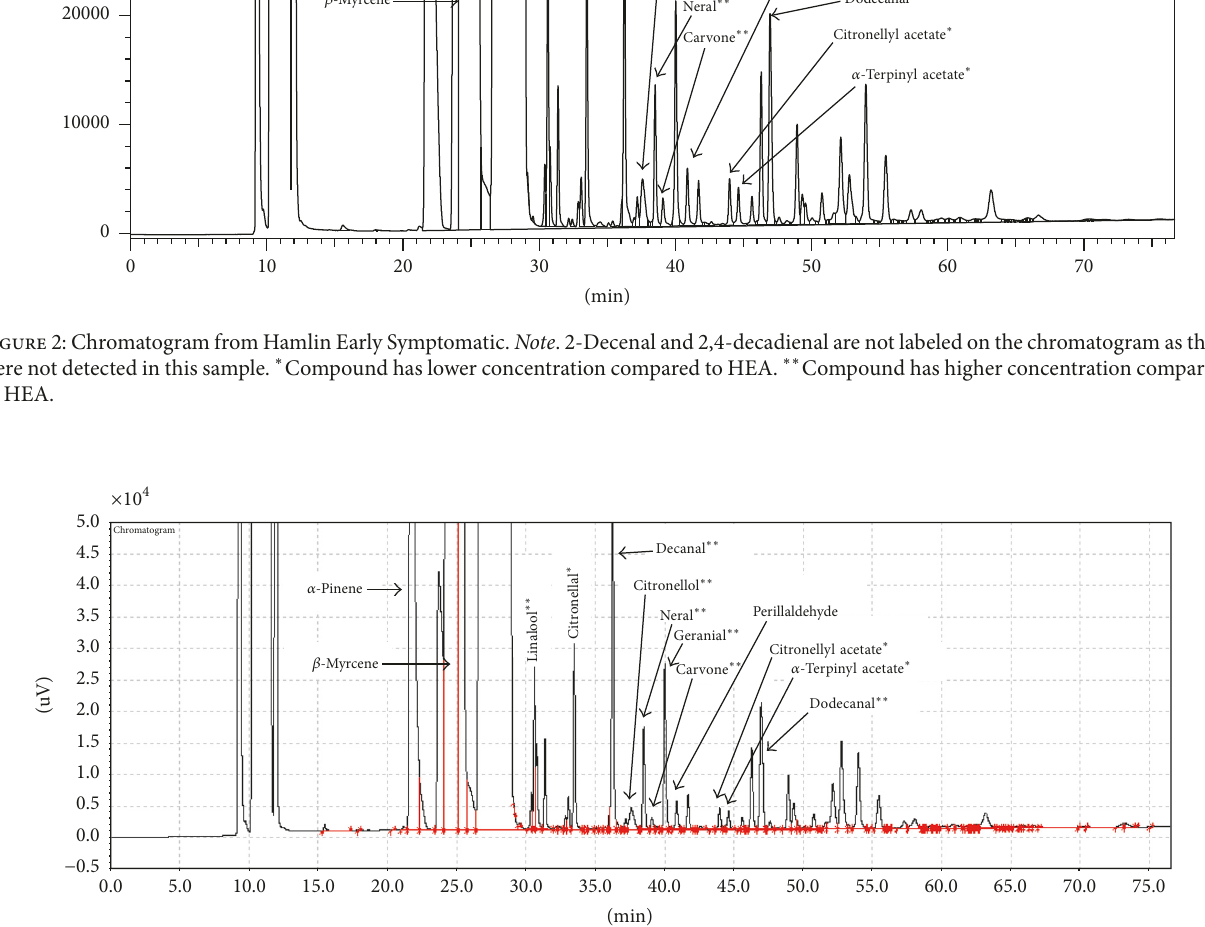
Figure 3: Chromatogram from Hamlin Late Asymptomatic. Note . While 2-decenal and 2,4-decadienal were quantifiable in this sample, they were not labeled on the chromatogram as the peaks are too small to be seen. ∗ Compound has lower concentration compared to HLS. ∗∗ Compound has higher concentration compared to